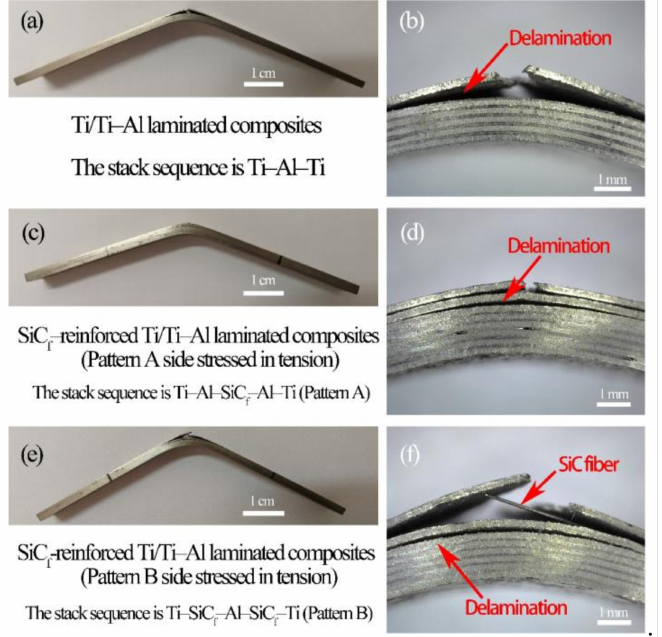
Figure 17. OM image of crack morphologies in three-point bending test: ( a ) and ( b ) Ti/Ti–Al laminated composites, ( c ) and ( d ) SiC f -reinforced Ti/Ti–Al laminated composites (Pattern A side stressed in tension), ( e ) and ( f ) SiC f -reinforced Ti/Ti–Al laminated composites (Pattern B side stressed in